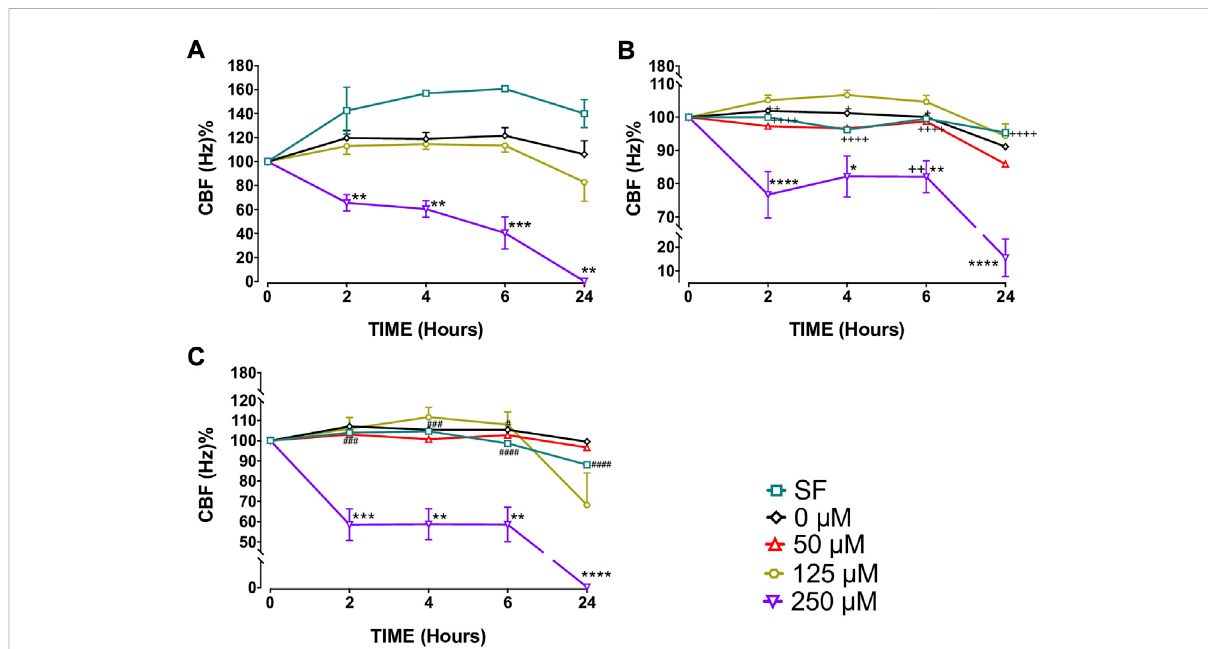
FIGURE 1 Effects of capsaicin (50, 125 and 250 µM) on ciliary beat frequency (CBF) of bronchial epithelial cell (BEC) cultures of non-smokers (A) , smokers (B) and patients with COPD (C) . Mean±SEM is displayed for non-smoker ( N = 5), smoker ( N = 13) and patients with COPD ( N = 7). (* p < 0.05, ** p